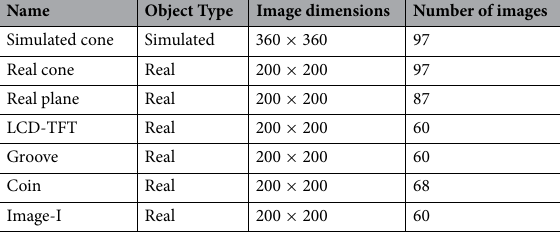
Table 2. Summary of experimented objects.